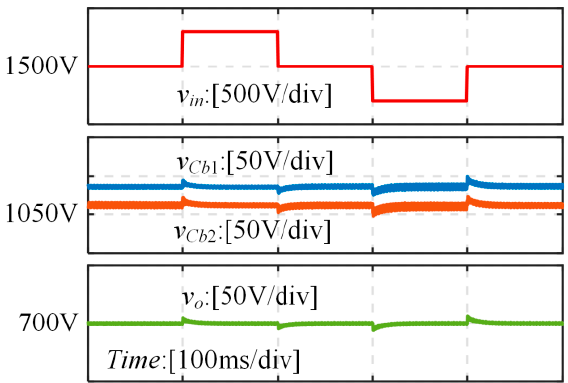
Figure 10. Simulation waveforms when input voltage changes.